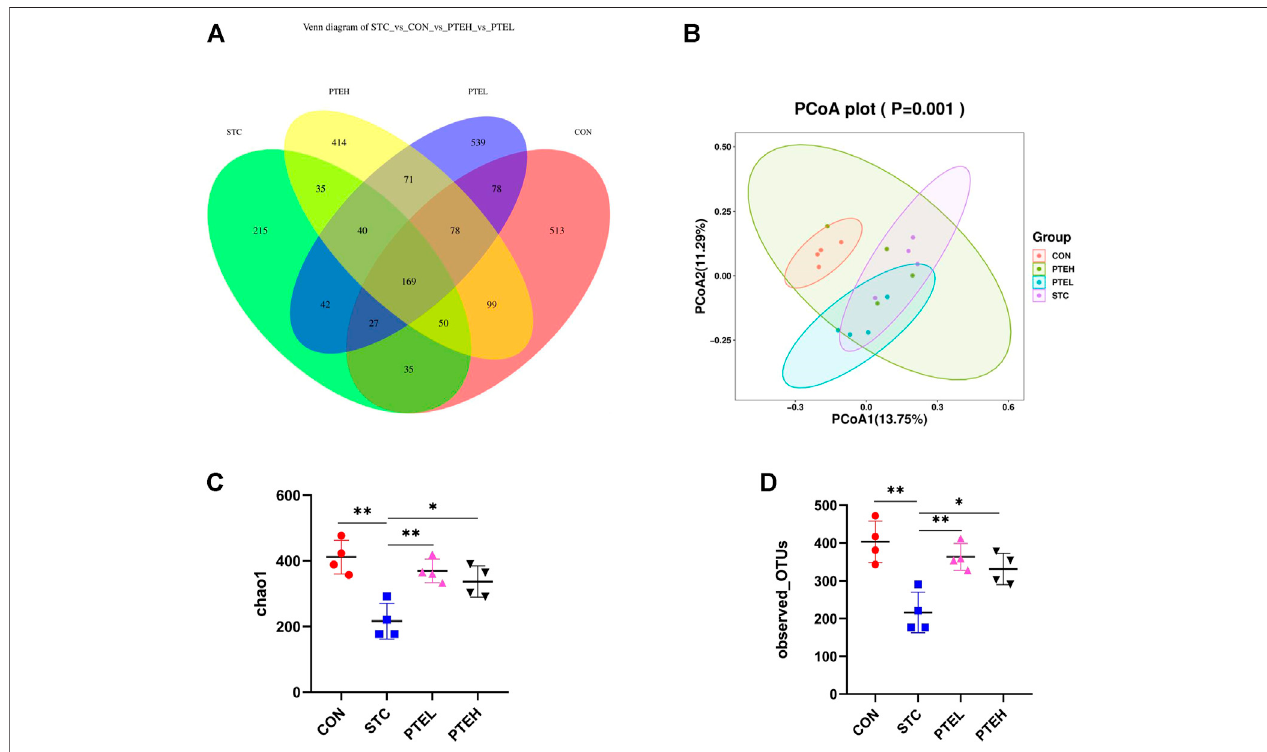
FIGURE 9 | Regulation of gut microbiota structure by PTE. (A) The Venn diagram of different mice micro fl ora; (B) The beta diversity of microbiomes in different samples, which were based on unweighted UniFrac metrics; (C,D) Alpha diversity indexes: (C) chao1 index, (D) Observed OTUs. ( n = 4). * p < 0.05, ** p < 0.01. (OTUs, operational taxonomic units; PCoA, principal co-ordinates